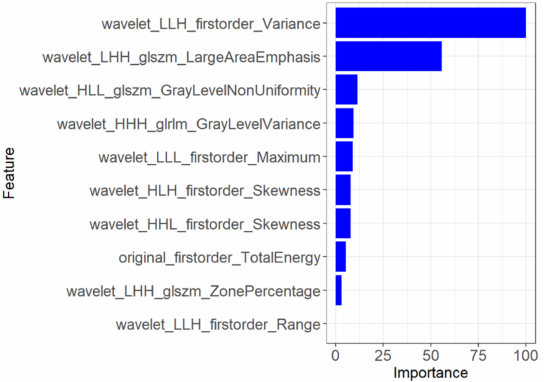
Figure 9. The 10 feature parameters and corresponding coefficients after screening in the second